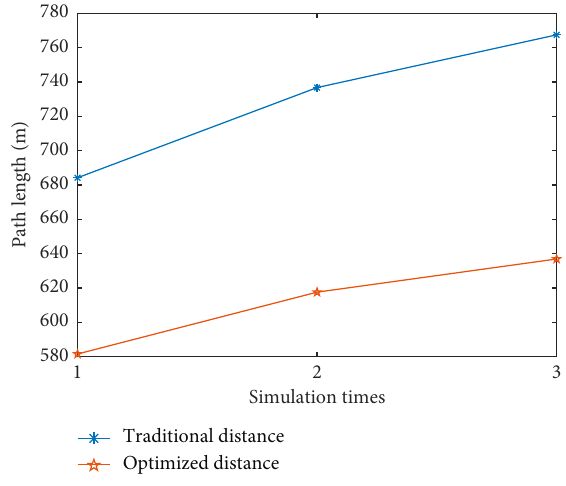
Figure 13: Comparison of path length before and after optimization.